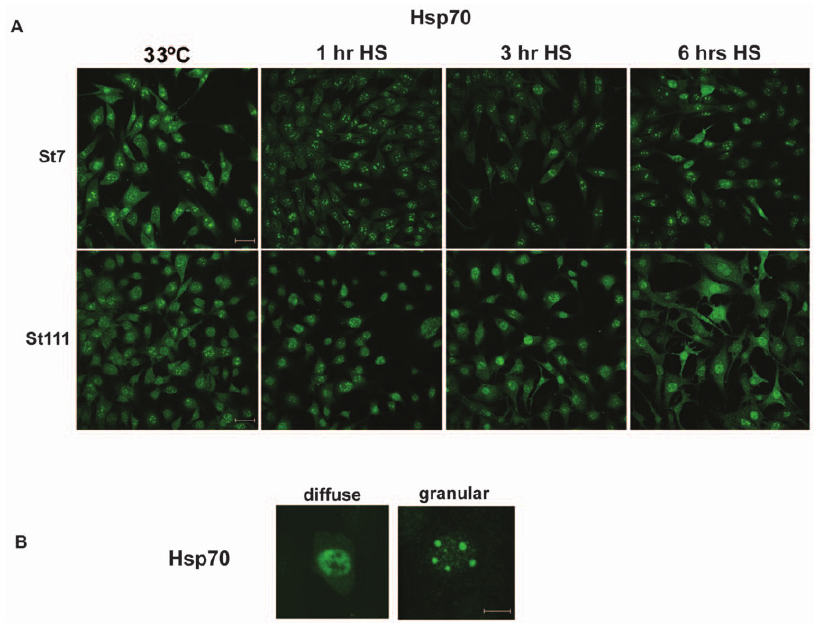
Figure 4. Aberrant Hsp70 localization upon heat shock in cells expressing polyQ-expanded Htt. A ) Immunofluorescence microscopy of fixed cells that were grown at 33 u C and heat shocked cells (HS, 42 u C) for either one, three, or six hours probed with anti-Hsp70 antibodies. The scale bars represent 75 m m. The 33 u C samples were exposed longer to visualize Hsp70 localization. B ) Immunofluorescence microscopy of fixed cells as in Figure 4 A. Pictures were taken at a higher magnification (scale bars represent 15 m m) to demonstrate the difference between diffuse and granular Hsp70 staining in the nucleus.